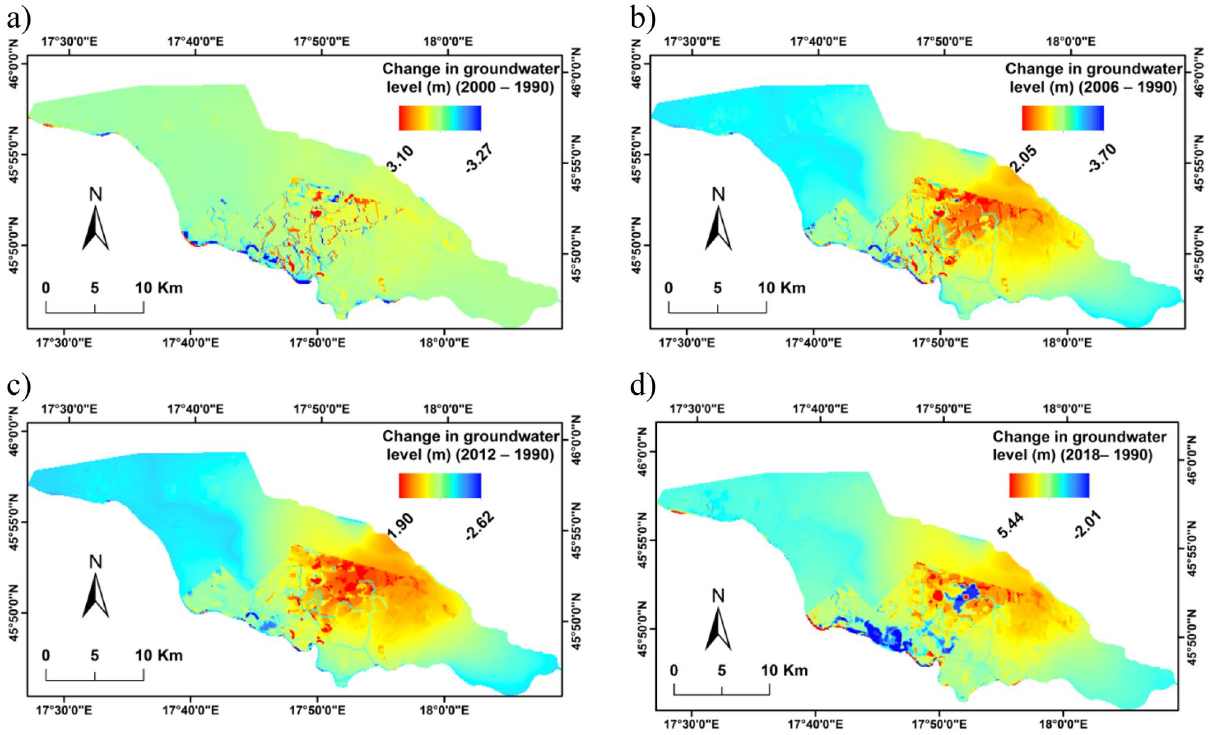
Figure 11. Change in groundwater level of the simulated LULC scenarios with respect to the base case (1990): ( a ) 2000–1990; ( b ) 2006–1990; ( c ) 2012–1990; and ( d )